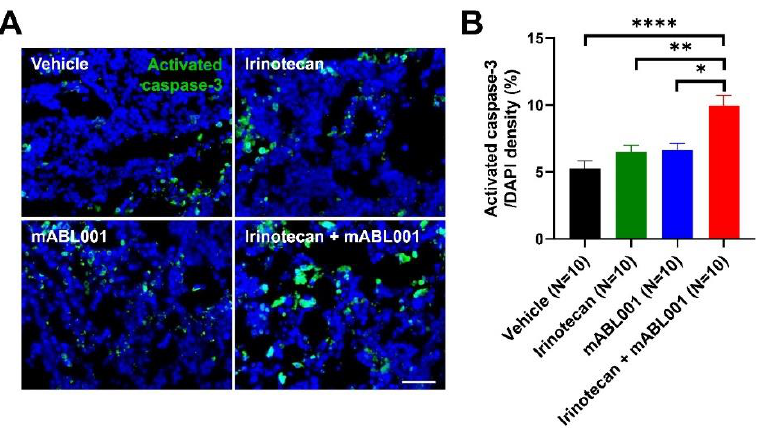
Figure 5. Combination therapy markedly increased apoptotic tumor cells in SW620 xenograft model. Representative immunofluorescence images ( A ) reveal apoptotic cells stained for activated caspase-3 (green) with DAPI (blue) in SW620 tumor tissues. The area densities of activated caspase-3-positive apoptotic cells were measured in each group ( B ). Apoptotic cells in tumors were marginally increased after irinotecan or mABL001 treatment, but the increase was not significant compared to vehicle treatment. However, the combination treatment of mABL001 and irinotecan markedly increased the apoptotic cell population in tumors. Scale bar indicates 50 µm. Error bars: mean ± SEM. * p <